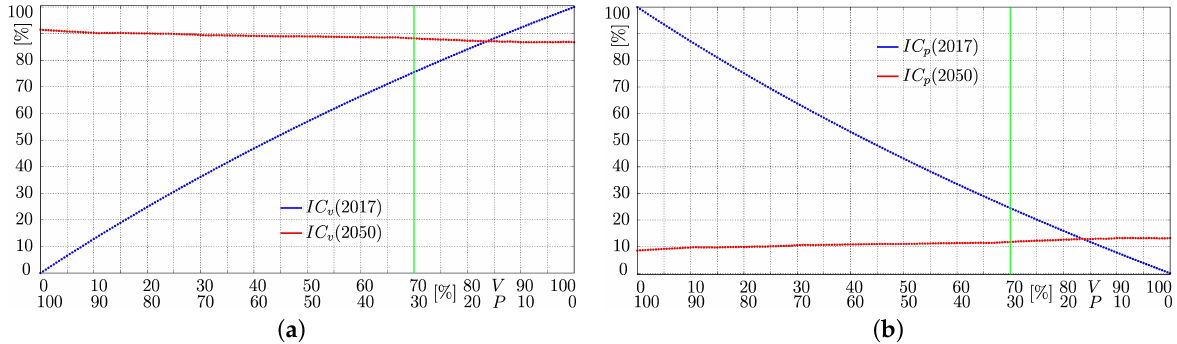
Figure 15. Leverage points of all V / P scenarios. The green vertical line represents the Colombian case (70%V, 30%P). ( a ) IC v (%) and ( b ) IC p